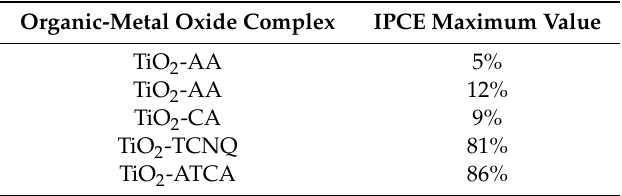
Table 2. Incident photon-to-current conversion e ffi ciency (IPCE) maximum values reported for ICTT based photovoltaic conversion in organic-metal oxide